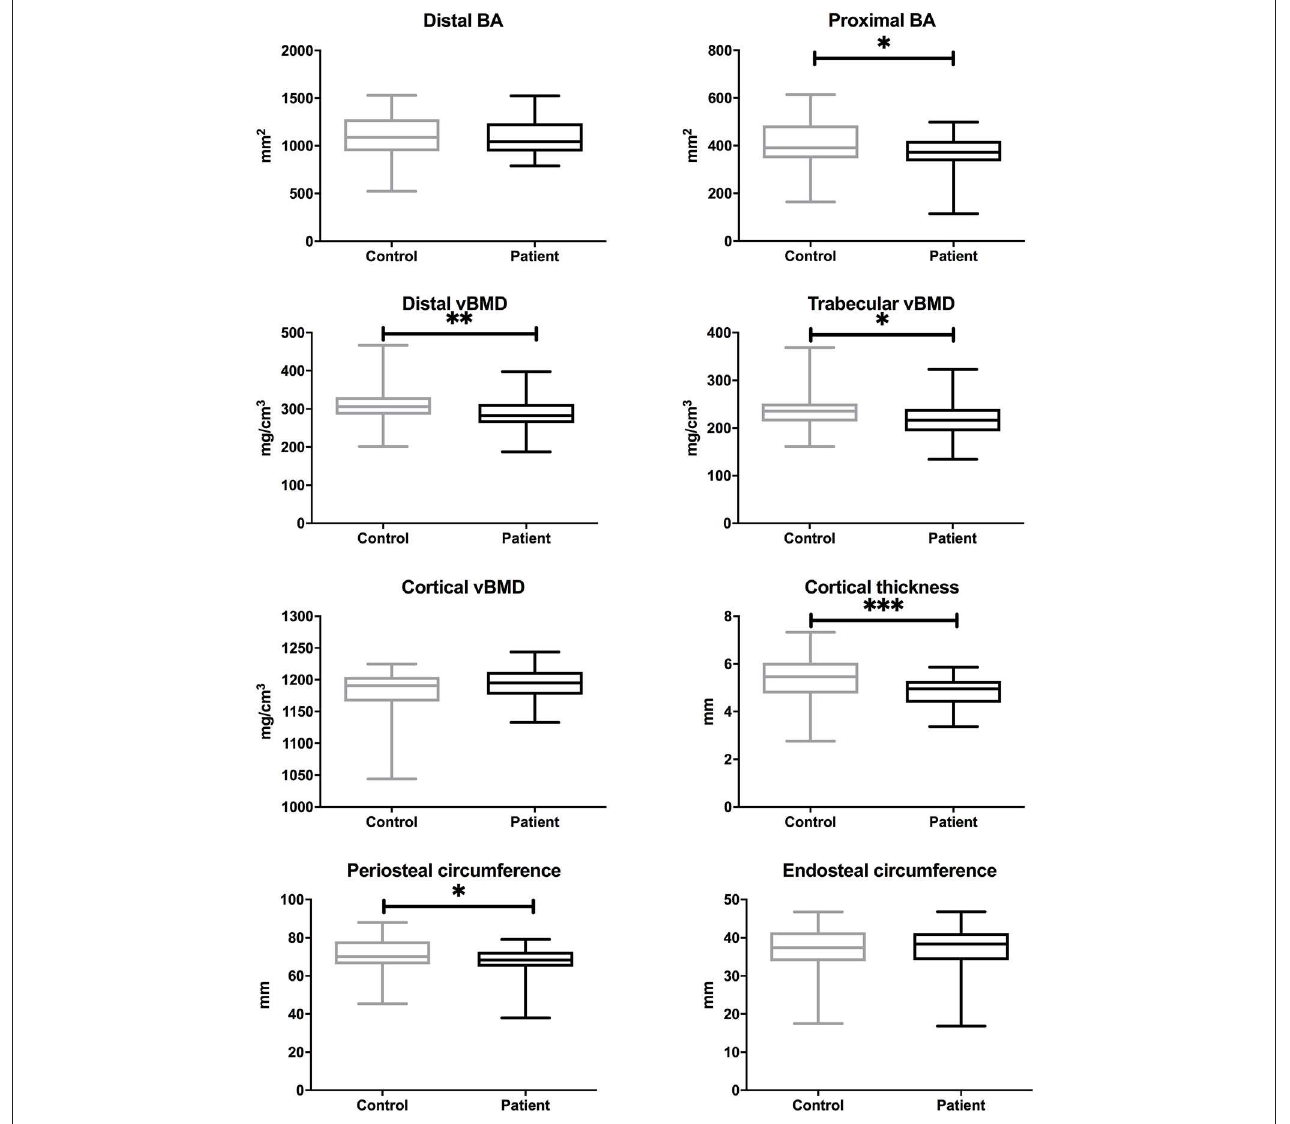
FIGURE 3 | Bone characteristics at tibial site in adults with APECED ( n = 37) in comparison to age- and gender-matched control subjects ( n = 68). Total bone area (BA), total, cortical and trabecular volumetric bone mineral density (vBMD), and cortical dimensions measured at proximal (38%) and distal (4%) site of tibia with pQCT. P values are indicated with asterisks: *, < 0.05; **, < 0.01; ***, < 0.001.